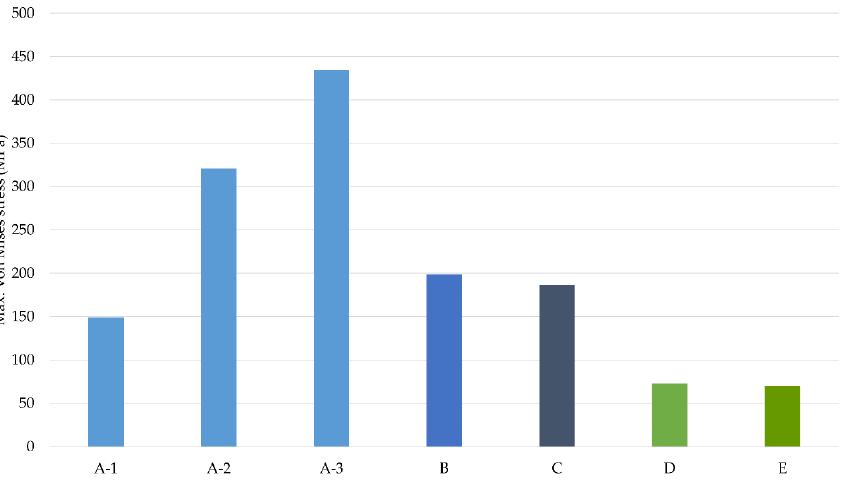
Figure 6. Maximum equivalent von Mises stress values. Blue shades—cases with implants between foramina. Green shades—cases with the 2 implants posterior to the distal of the foramen. For each scenario, the peri-implant bone volume with a strain value greater than 3000 µε was calculated. The peri -implant bone volume considered for this calculation corresponds to a cylinder of Ø7.75 mm and a length of 9.5 mm from the implant plat- form (Figure 7).